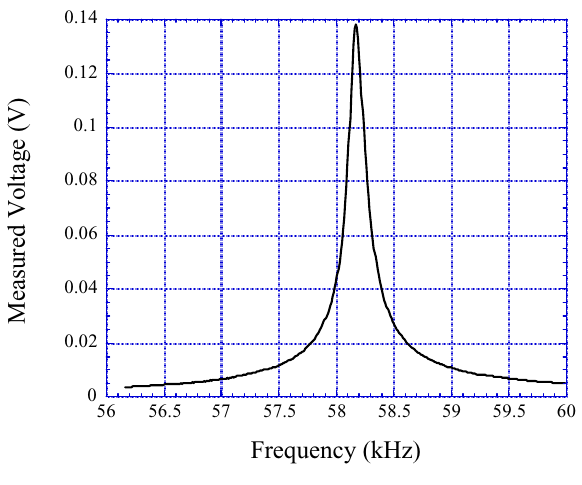
Figure 3. The frequency response of a 4 cm × 1.3 cm × 28 µm as-cast Metglas 2826MB ribbon. The resonant frequency is the maximal of the frequency